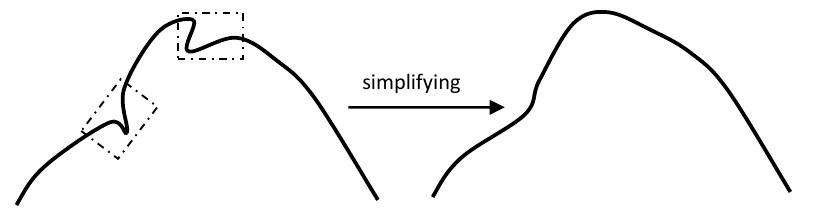
Figure 15. The method of simplifying minimum curves.